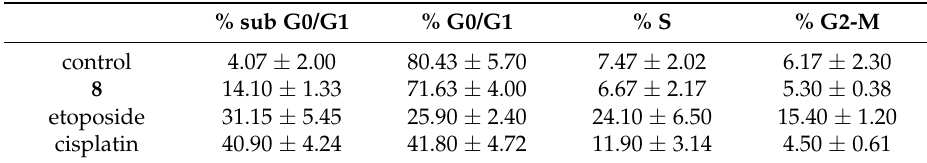
Figure 4. Cell viability of HL-60, A549, HSC-4 and HSC-2 cells after treatment with 1.0, 10, and 20 µ M of 1 and 8 for 0, 3, 6, 16, 24, 48, and 72 h. Data are represented as the mean value ± SEM of three experiments performed in triplicate. Table 4. Effects of 8 on cell cycle distribution of A549 cells a